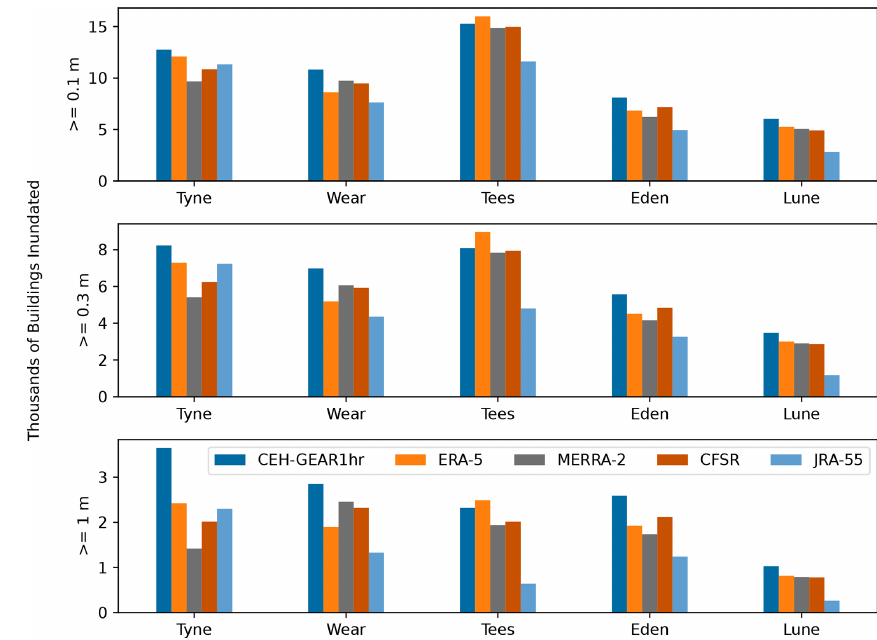
Figure 8. Number of buildings inundated above given thresholds per basin by each